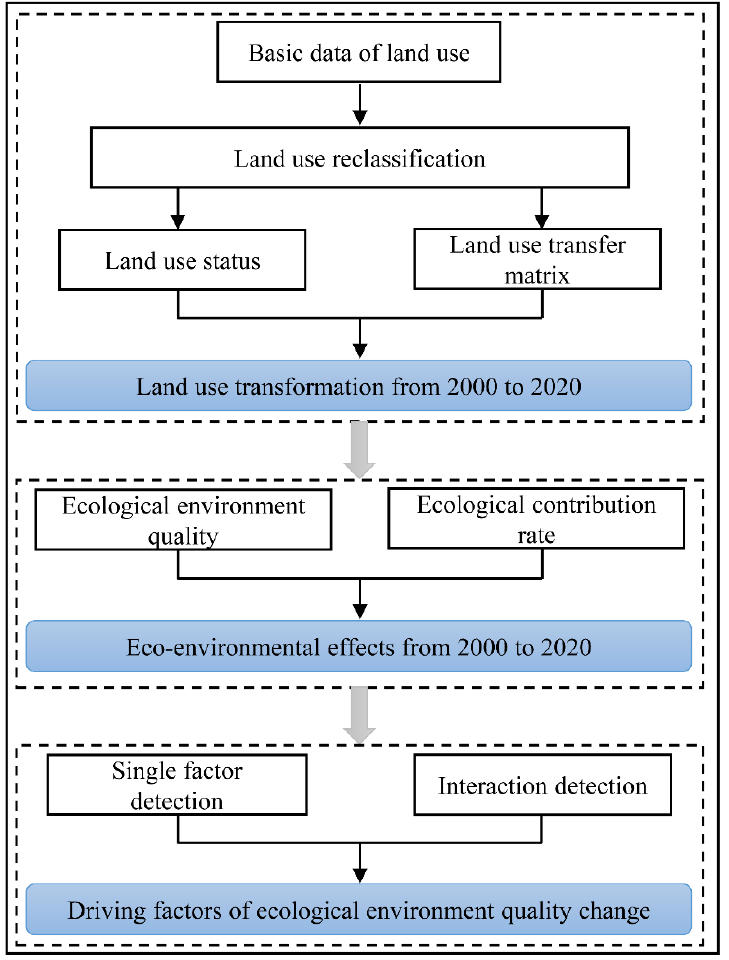
Figure 2. The workflow of the study .